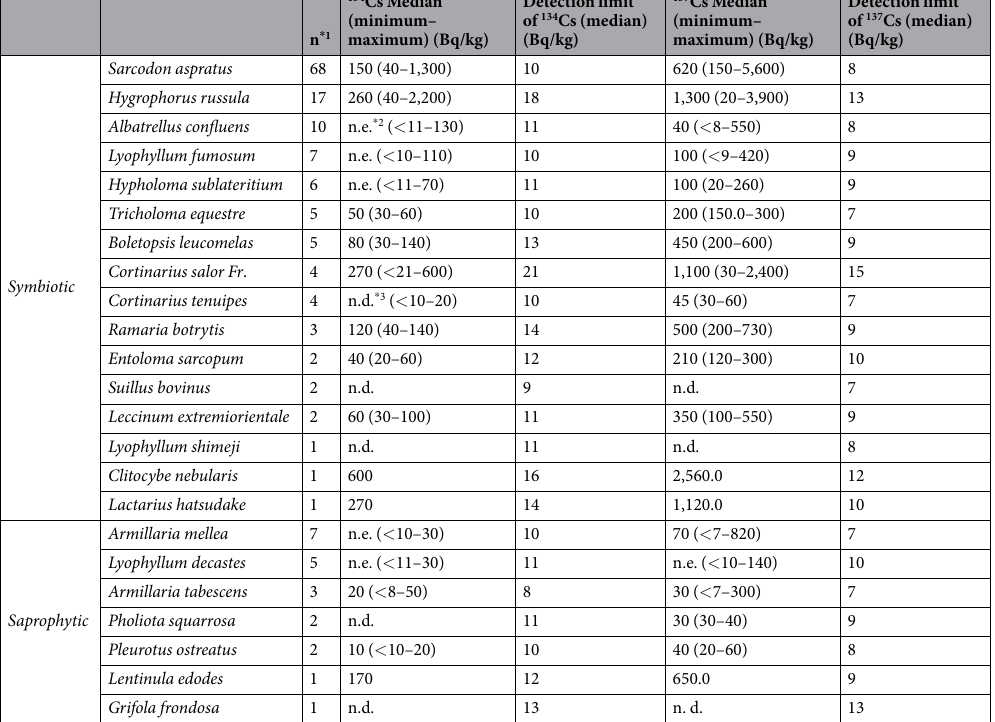
Table 1. Concentrations of radiocesium in wild mushroom samples collected in 2015. * 1 n: the number